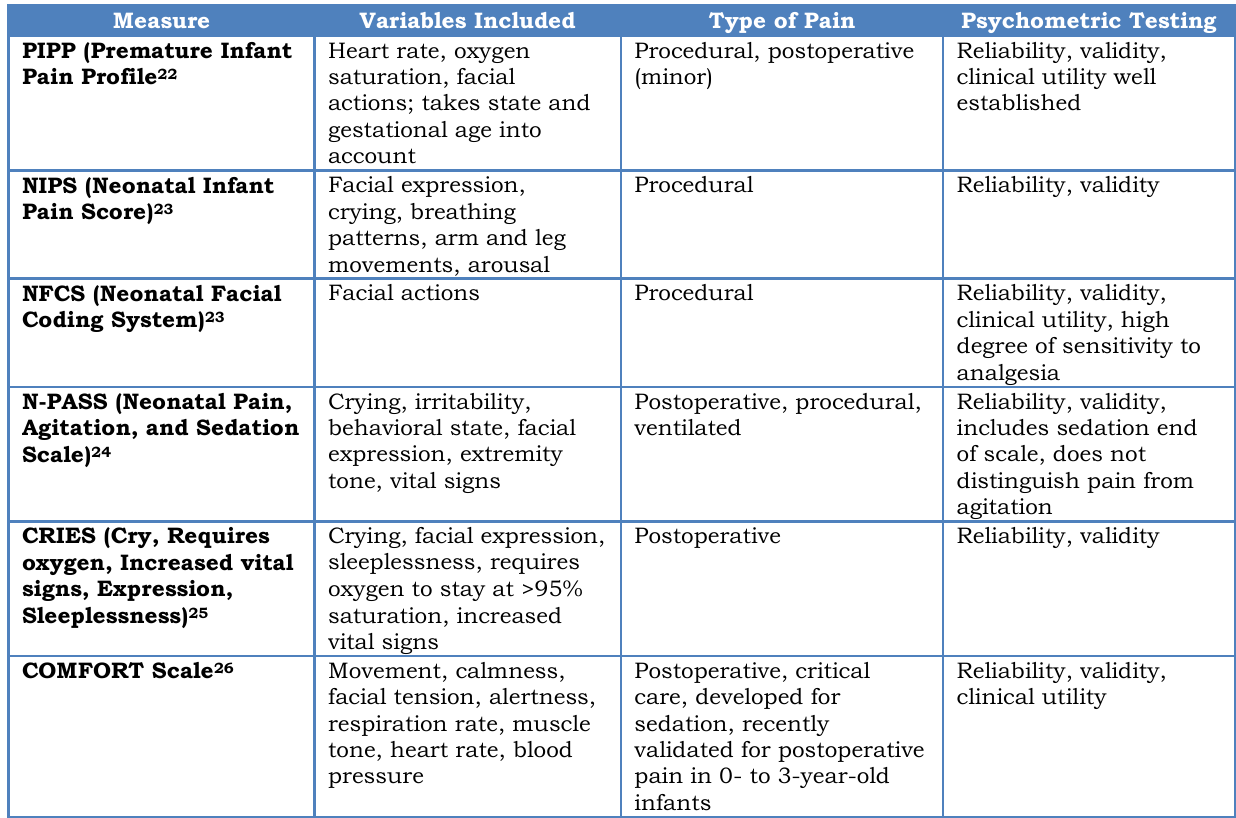
Table 1: Commonly Used Measures of Pain in